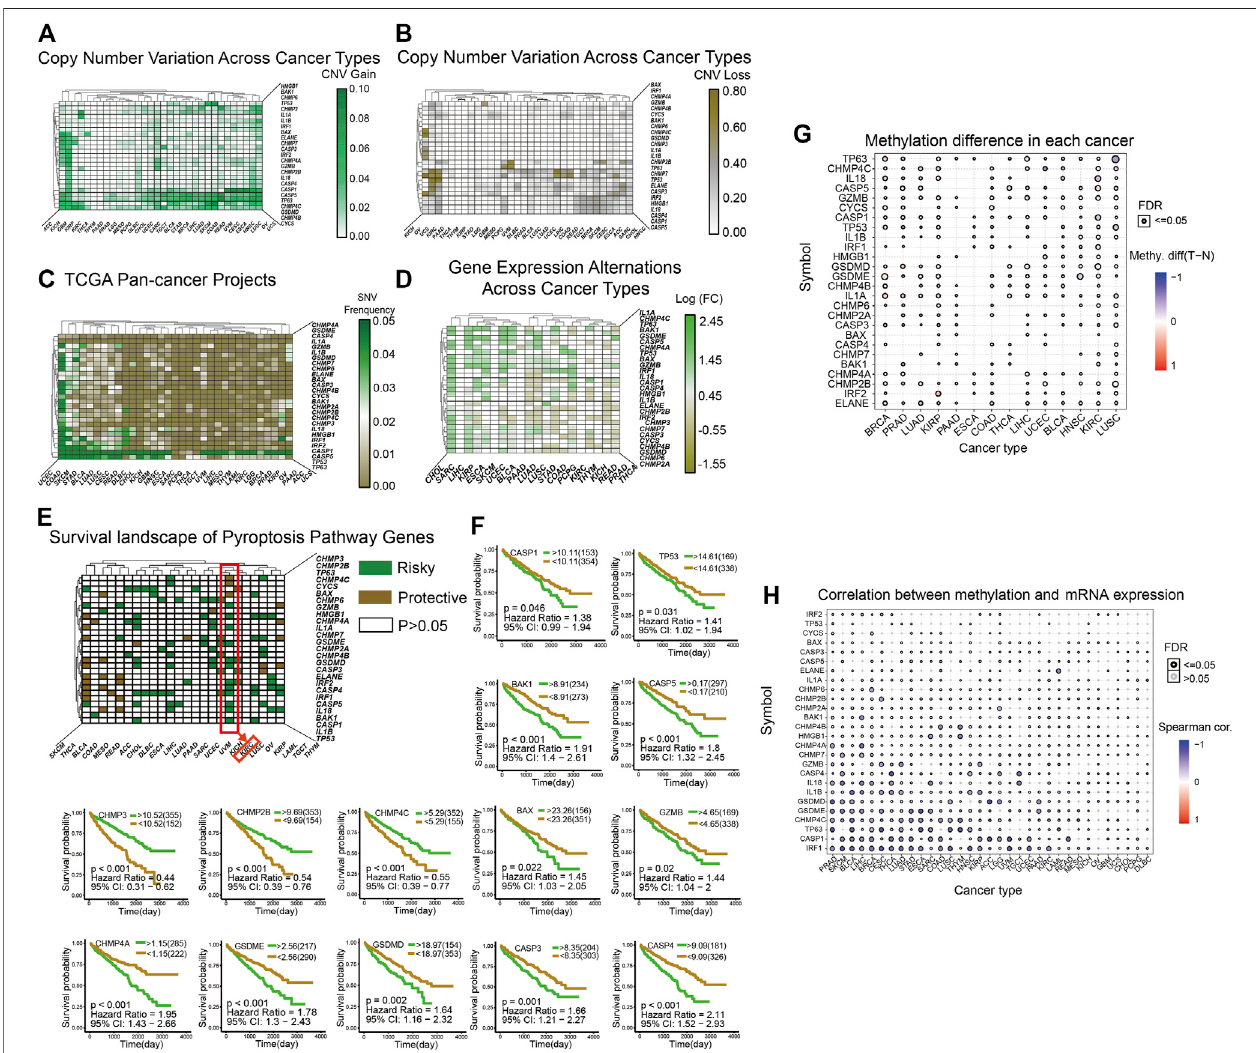
FIGURE1|(A – B) :TheheatmapshowstheCNVmutationsofpyroptosis-relatedgenesobtainedinthepan-cancerprojectofTCGAdatabase.ThegreencolorinA indicates a higher degree of CNV gain, the brown color in B indicates a higher degree of CNV loss. The color bar on the right of the fi gure shows the speci fi c values. (C) : TheheatmapshowstheSNVmutationsofpyroptosis.Thecolorbarontherightshowsthecolorcorrespondingtothespeci fi cvalue:thegreenerthecolor,thecloseritis to0.05, and thebrownerthecolor, thecloser itisto0.00. (D) :The heatmapshows theexpression levelsofpyroptosis-related genesin 20cancers,and theresults areprocessedbylog2foldchange.Atransitionfromgreentobrowncorrespondstoavaluebetween − 1.55and2.45. (E) Thisheatmapshowsthatallpyroptosis-related genes are divided into three categories from the perspective of survival landscape: Risky genes (Green), protective genes (Brown), and no statistically signi fi cant genes (White, p > 0.05). The categories of genes in KIRC are marked with a red box. (F) This includes the survival curve analysis of all statistically signi fi cant genes in KIRC in TCGAsamples. The upper right corner ofeach survivalcurve fi gure indicates that green represents thehigh expression groupand brownrepresentsthe lowexpression group. (G – H) The two graphsshow thedifferentdegrees ofmethylation in each cancer and the correlation between methylationand mRNA expression levels.The color depth of the ring on the right indicates the comparison between the p -value and 0.05, and the color bar indicates the degree of difference and correlation coef fi cient.